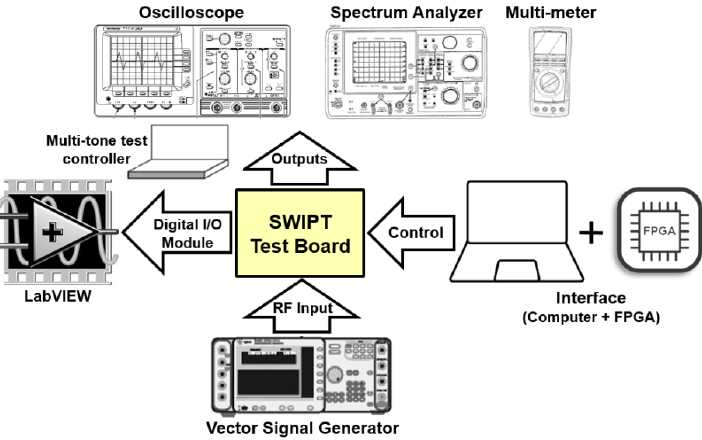
Figure 9. Measurement board of 900 MHz dual-mode SWIPT system. 332